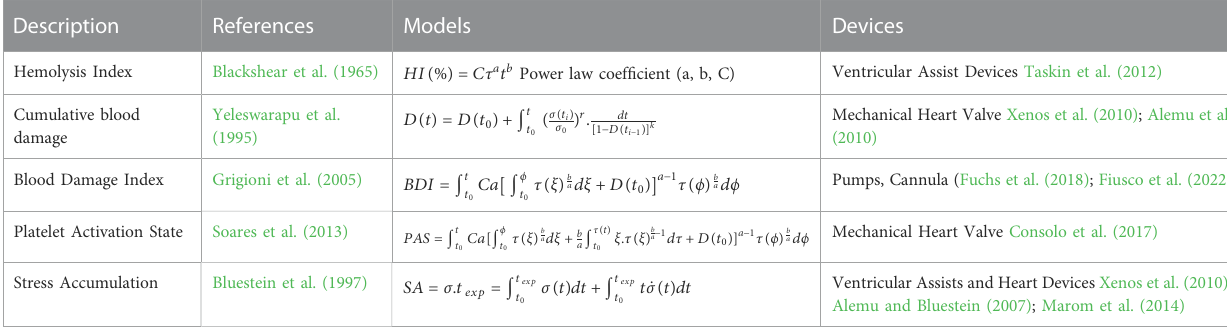
TABLE 3 Existing models based on a cumulative approach for blood